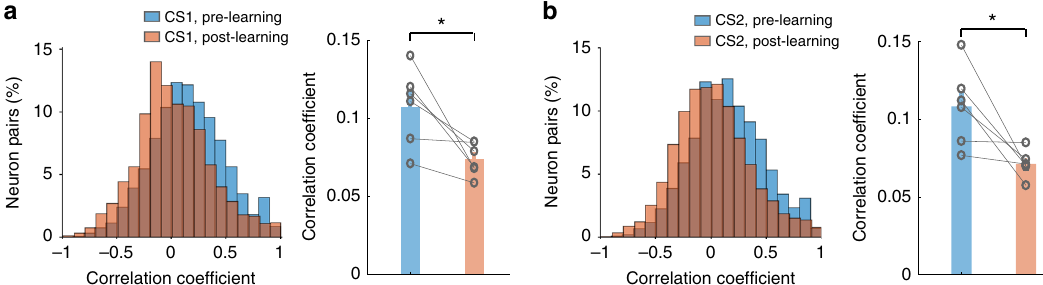
Fig. 6 Learning reduces noise correlations in the BLA. a Left, histograms of noise correlations in the responses to CS1 in BLA neurons in a representative mouse. Right, comparison of noise correlations between pre-learning and post-learning conditions ( n = 6 mice, t (5) = 3.2, * P = 0.0241, paired t -test). b Left, histograms of noise correlations in the responses to CS2 in BLA neurons in a representative mouse. Right, comparison of noise correlations between pre- learning and post-learning conditions ( n = 6 mice, t (5) = 3.04, * P = 0.0288, paired t - test). The bar graphs on the right in a and b represent mean ±